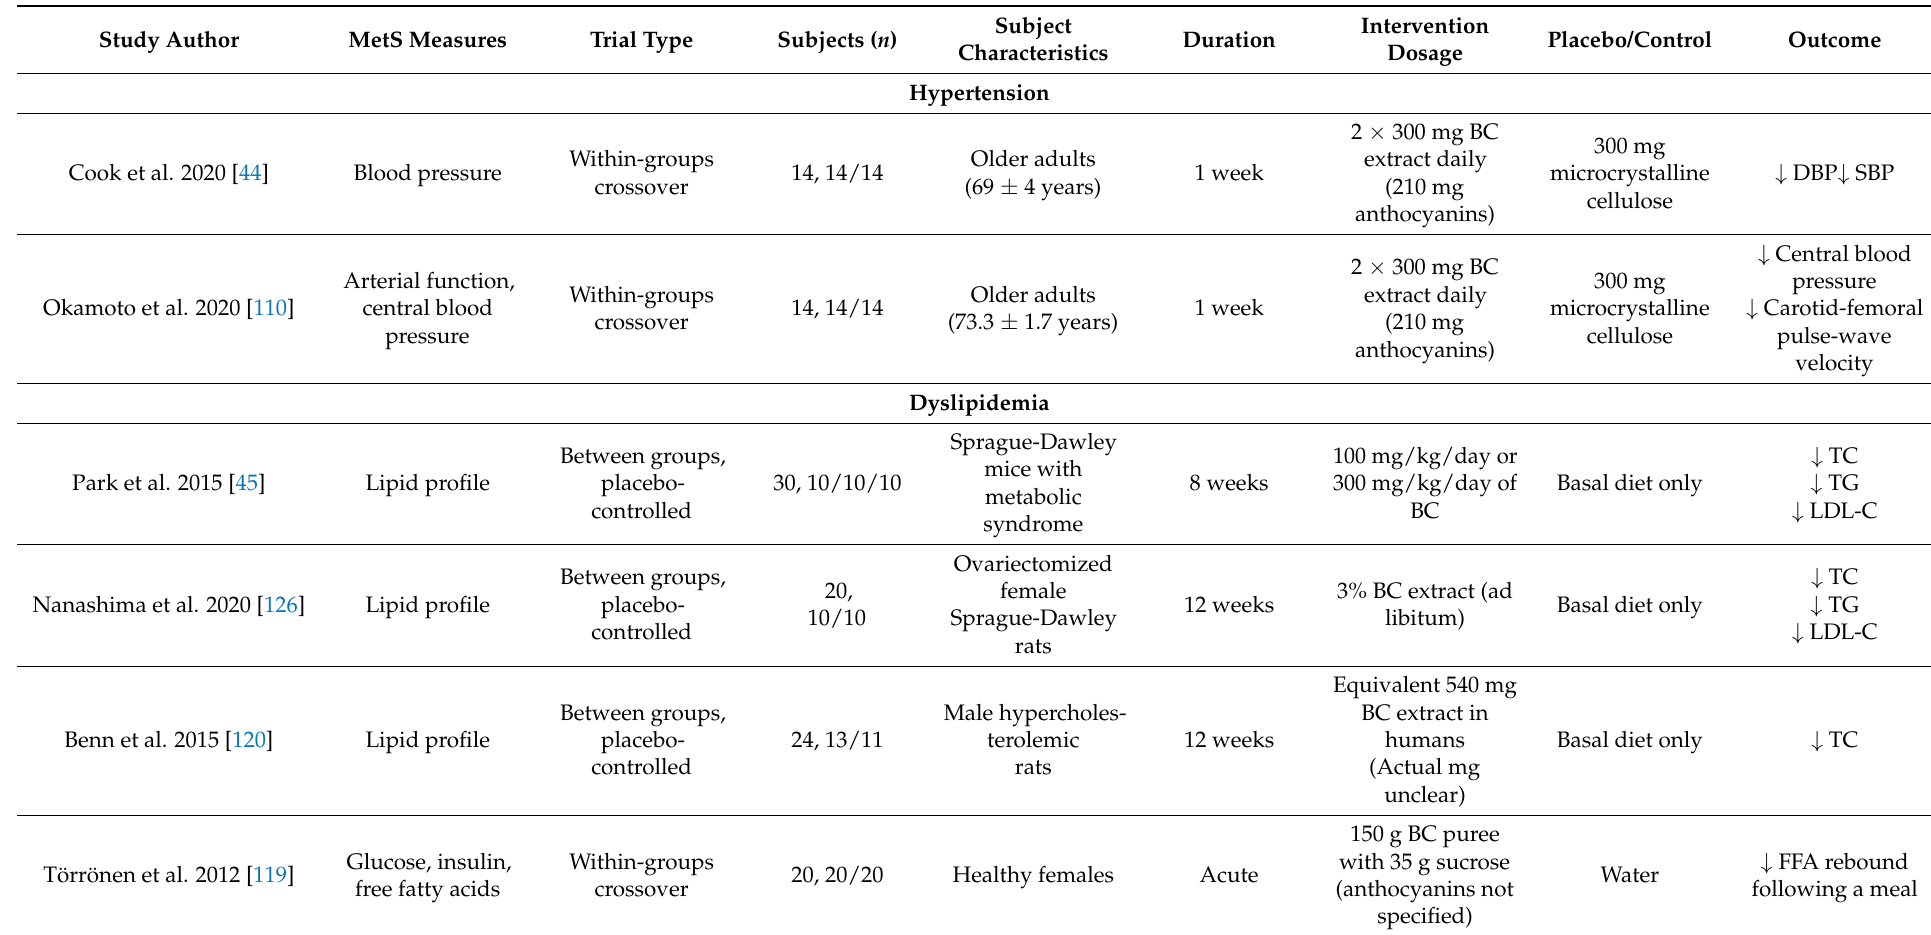
Table 7. Details of trials investigating blackcurrant juice and extracts on hypertension and